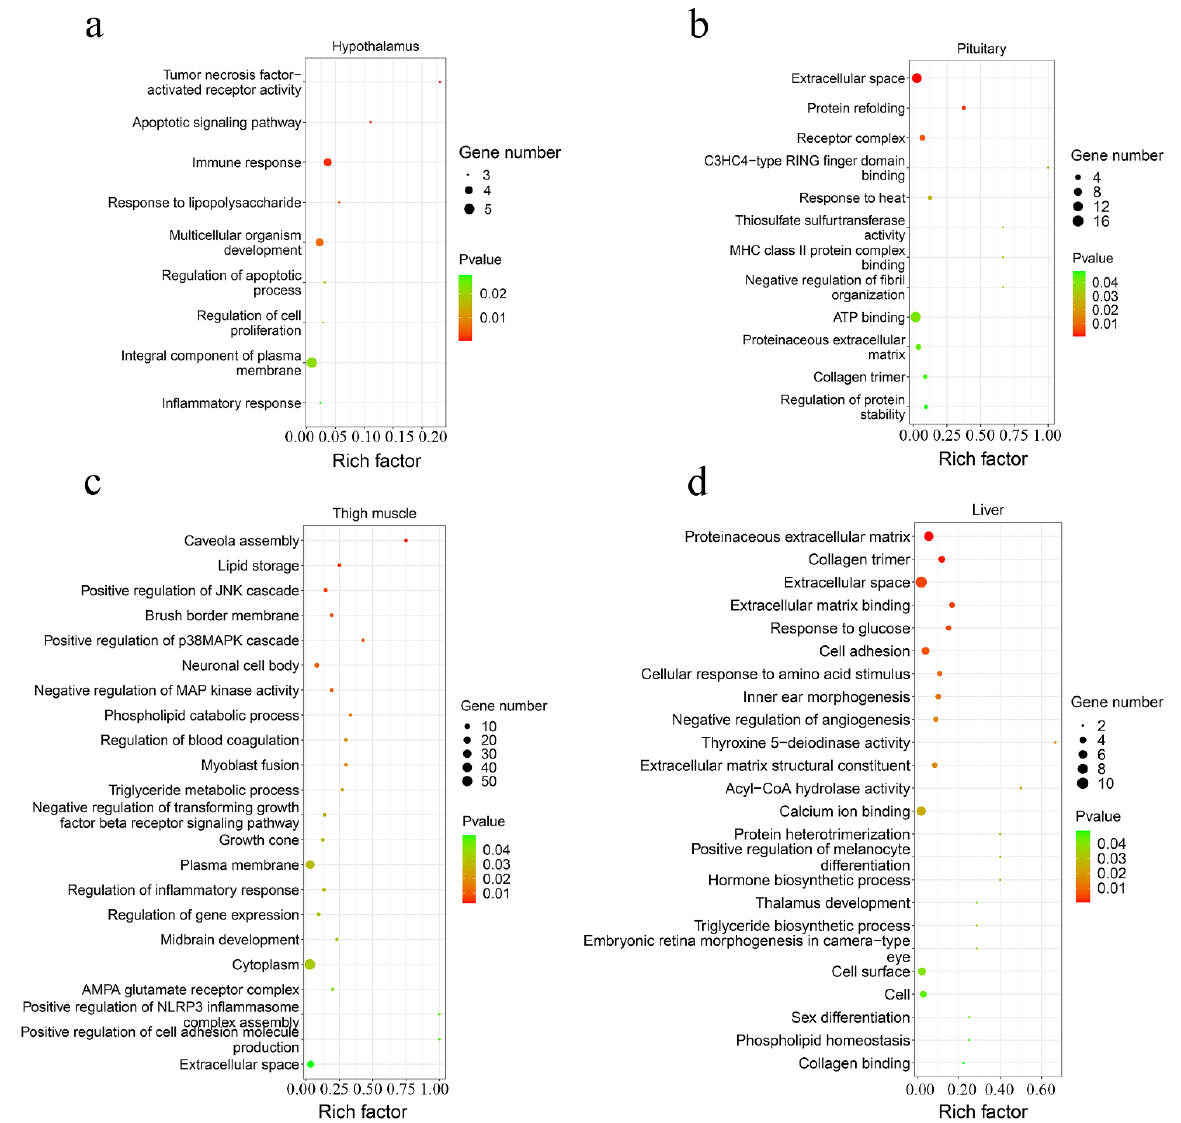
Figure 4. The scatter plot of GO functional enrichment. The enriched GO terms of DEGs in the hypothalamus ( a ), pituitary ( b ), thigh muscle ( c ), and liver ( d ).